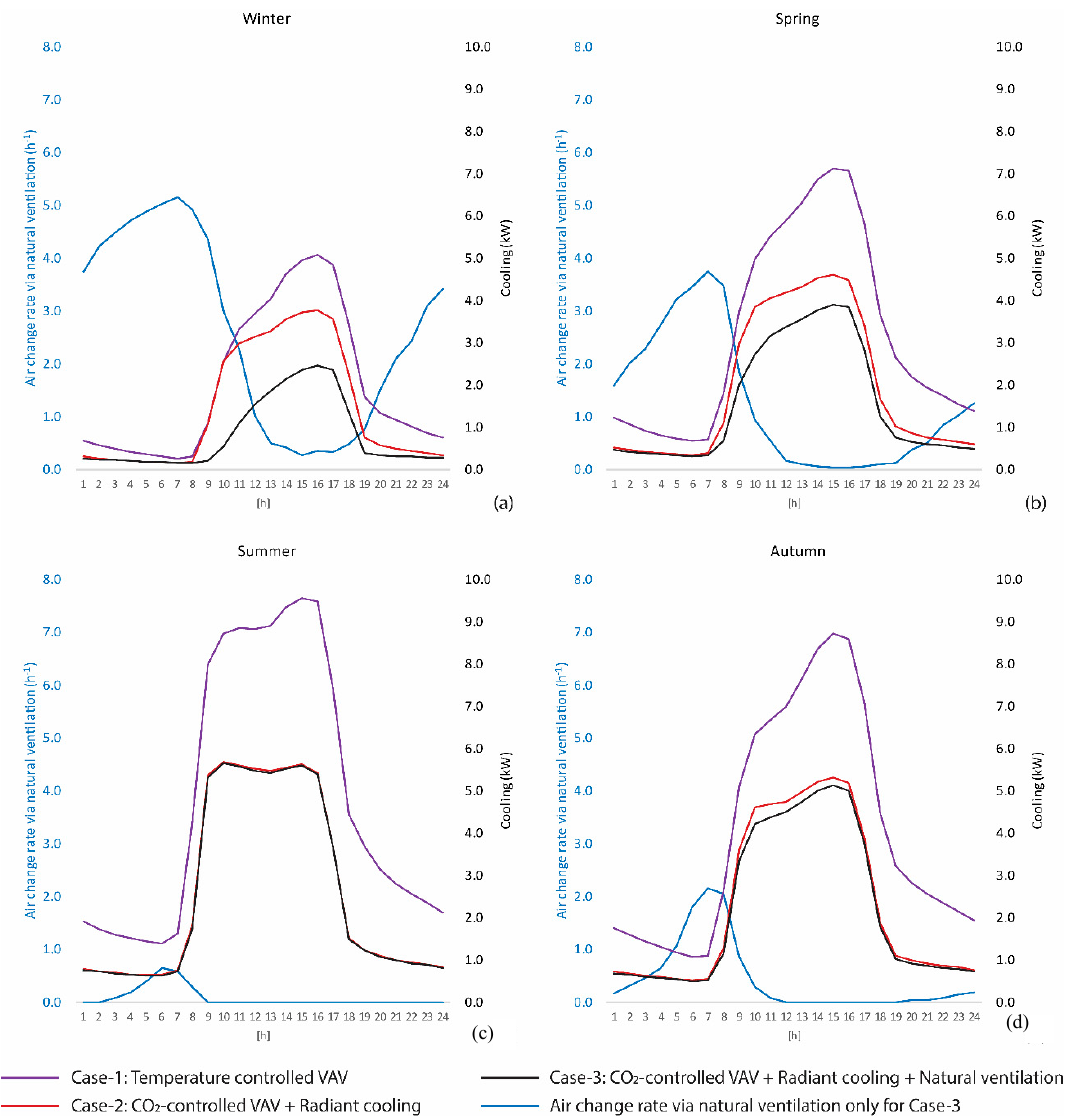
Figure 7. Daily average air change rate via natural ventilation against the cooling load on an average day for each season: ( a ) Winter, ( b ) Spring, ( c ) Summer, ( d ) Autumn.